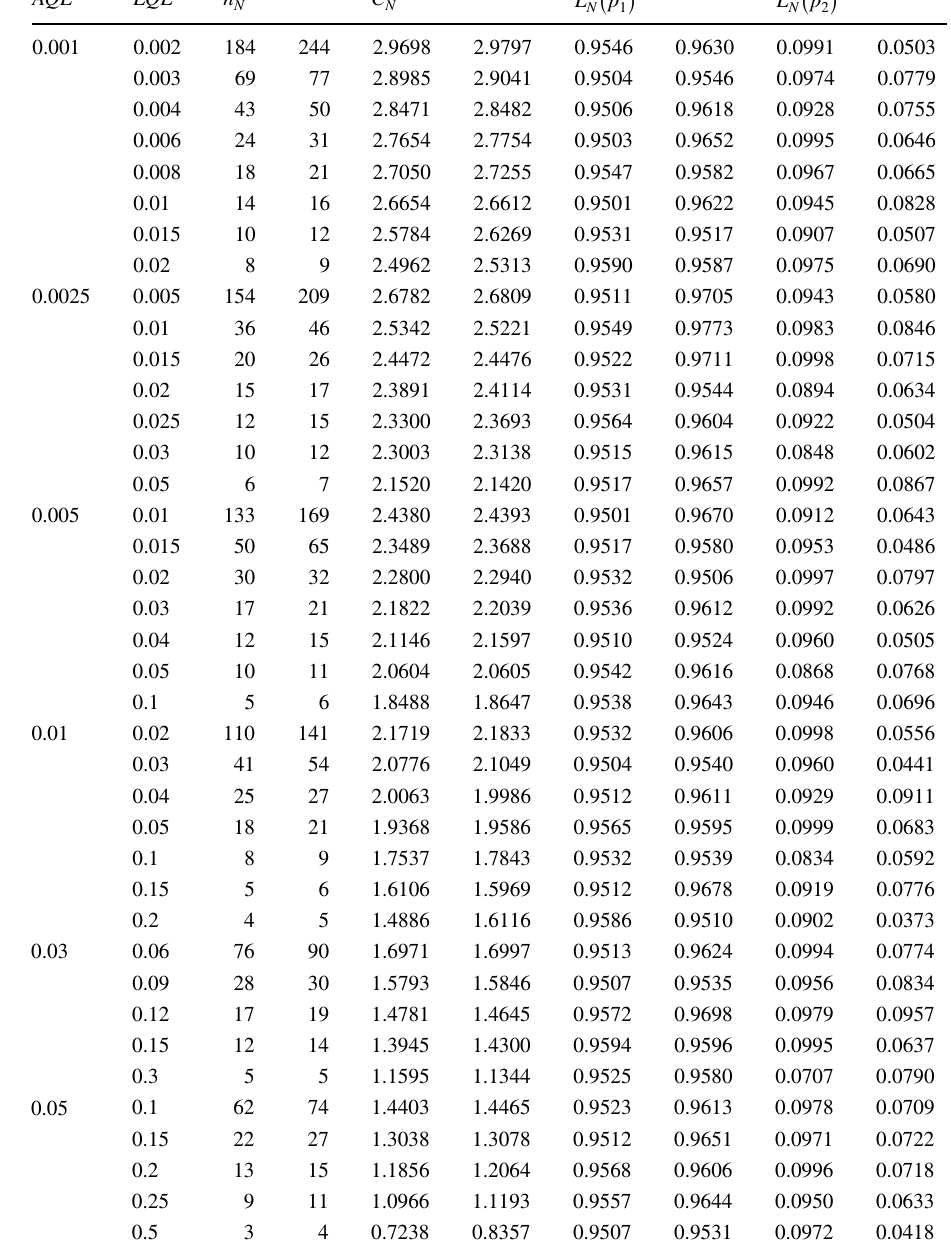
Table 2 Plan parameters for proposed plan, when 𝜎 Y N is = known and 𝜌 X N Y N